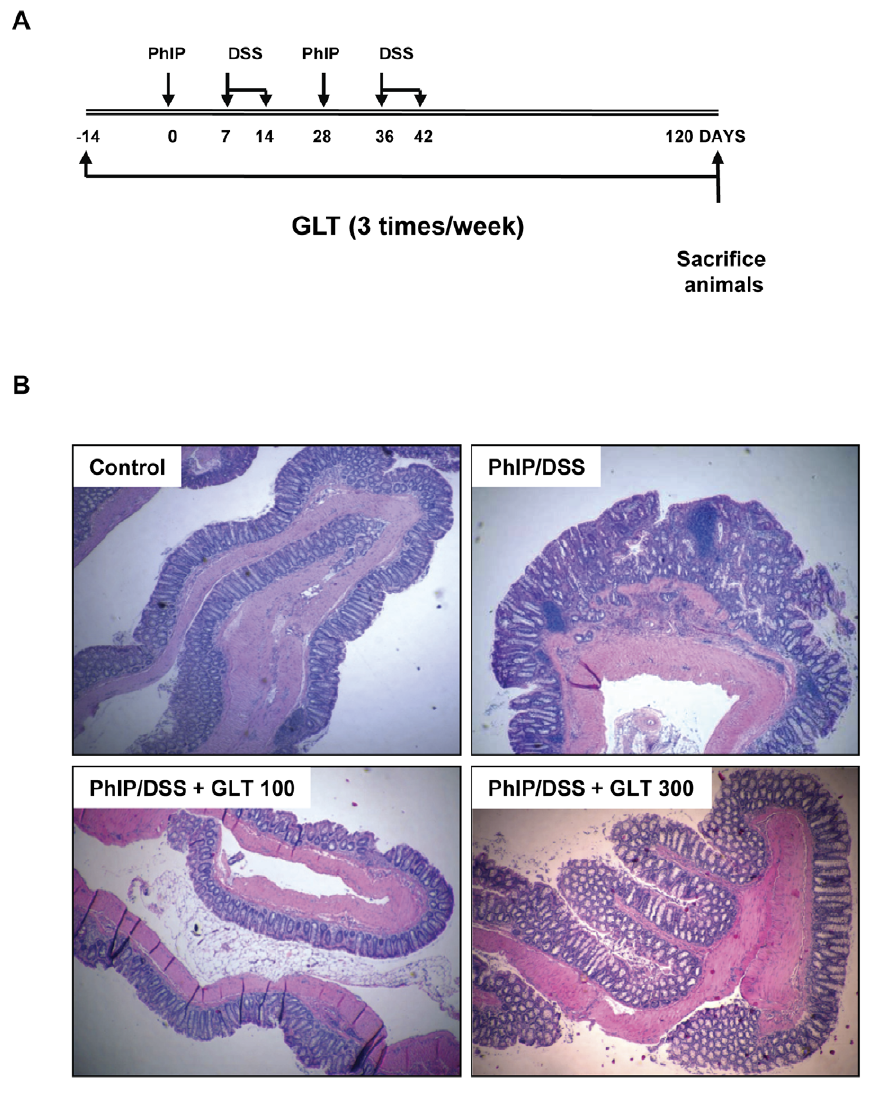
Figure 3. GLT prevents PhIP/DSS induced formation of colon tumors. (A) Schematic of the preventive experimental protocol. The details of the treatment are described in Materials and Methods . (B) H&E staining of representative samples from animal experiments. doi:10.1371/journal.pone.0047873.g003 PLOS ONE |